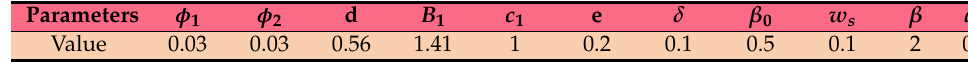
Table 5. Default Values of emerging parameters ([48]).